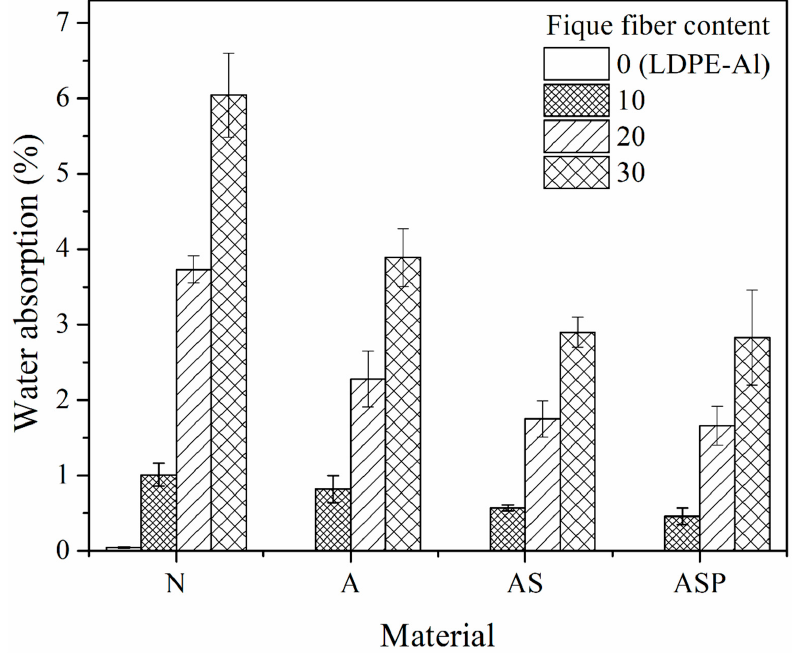
Figure 5. Absorption of water by immersion at 23 °C for the composite materials reinforced with fique fiber with or without surface modification.